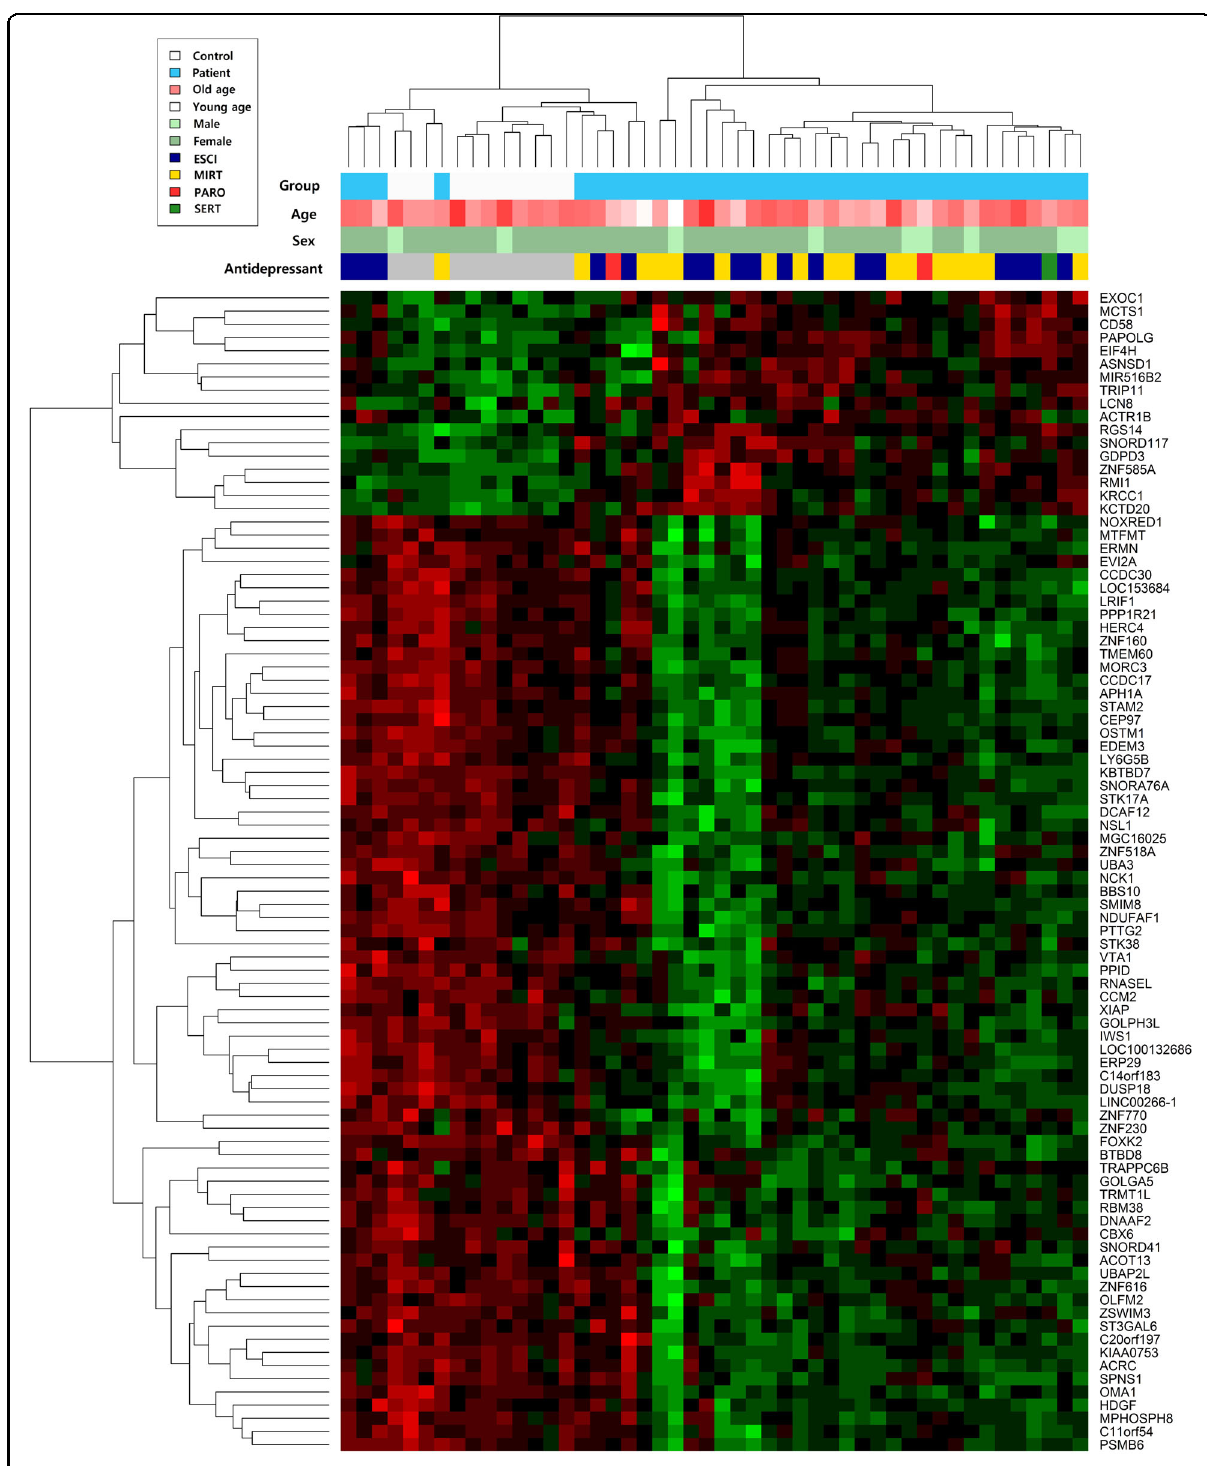
Fig. 1 Hierarchical clustering of 88 genes that were differentially expressed in major depressive disorder patients at baseline and controls; the criteria were both false discovery rate (FDR)-corrected p -value < 0.1 and absolute fold change (FC) > 1.2. Red indicates upregulated genes, green indicates downregulated genes, and black indicates genes with similar expression levels. Esci escitalopram, Mirt mirtazapine, Paro paroxetine, Sert